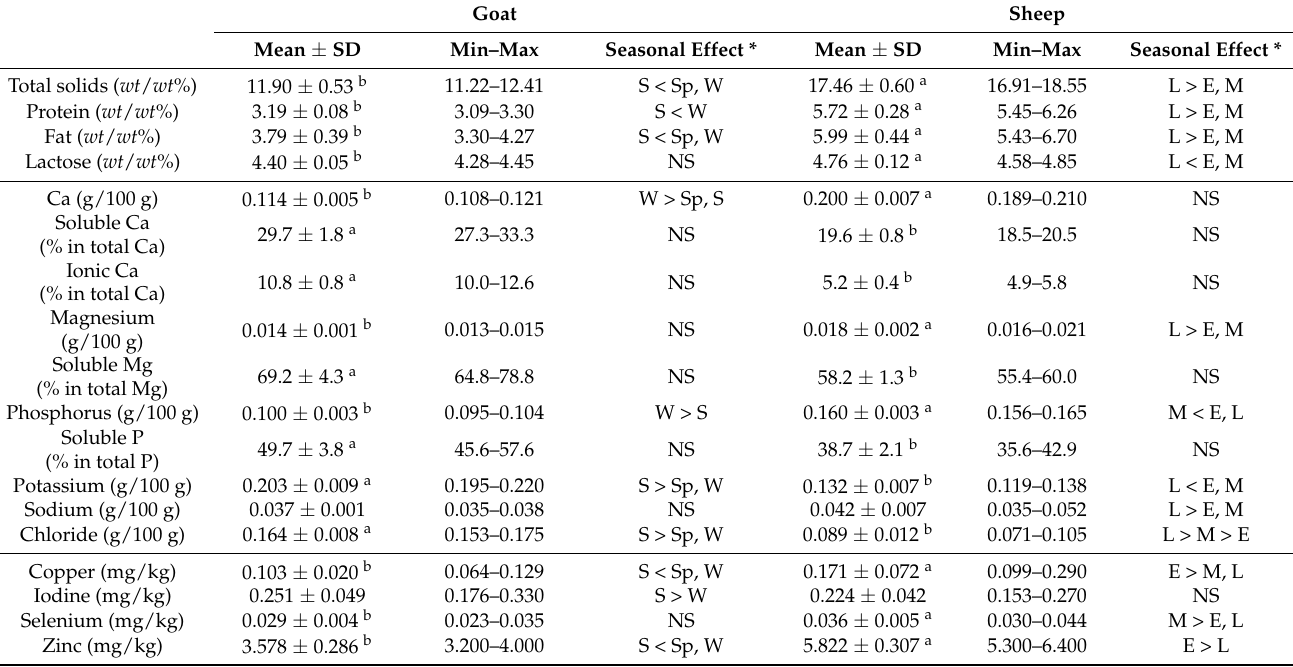
Table 1. Compositions of major components and minerals in the seasonal goat and sheep milks. Goat Sheep Mean ± SD Min–Max Seasonal Effect * Mean ±